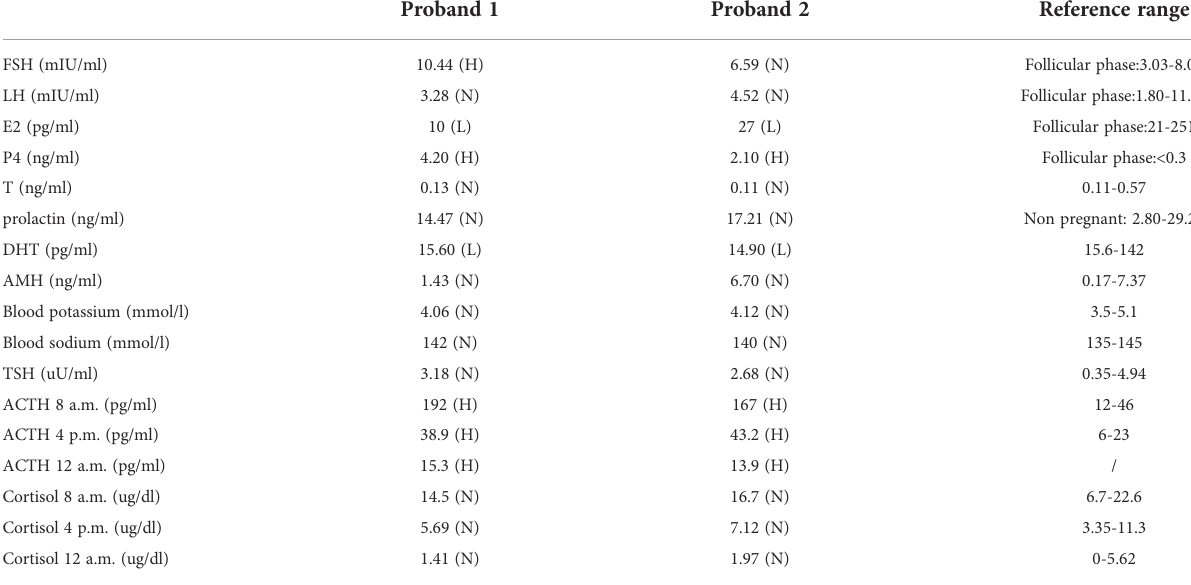
TABLE 2 Laboratory hormone pro fi les of the patients.